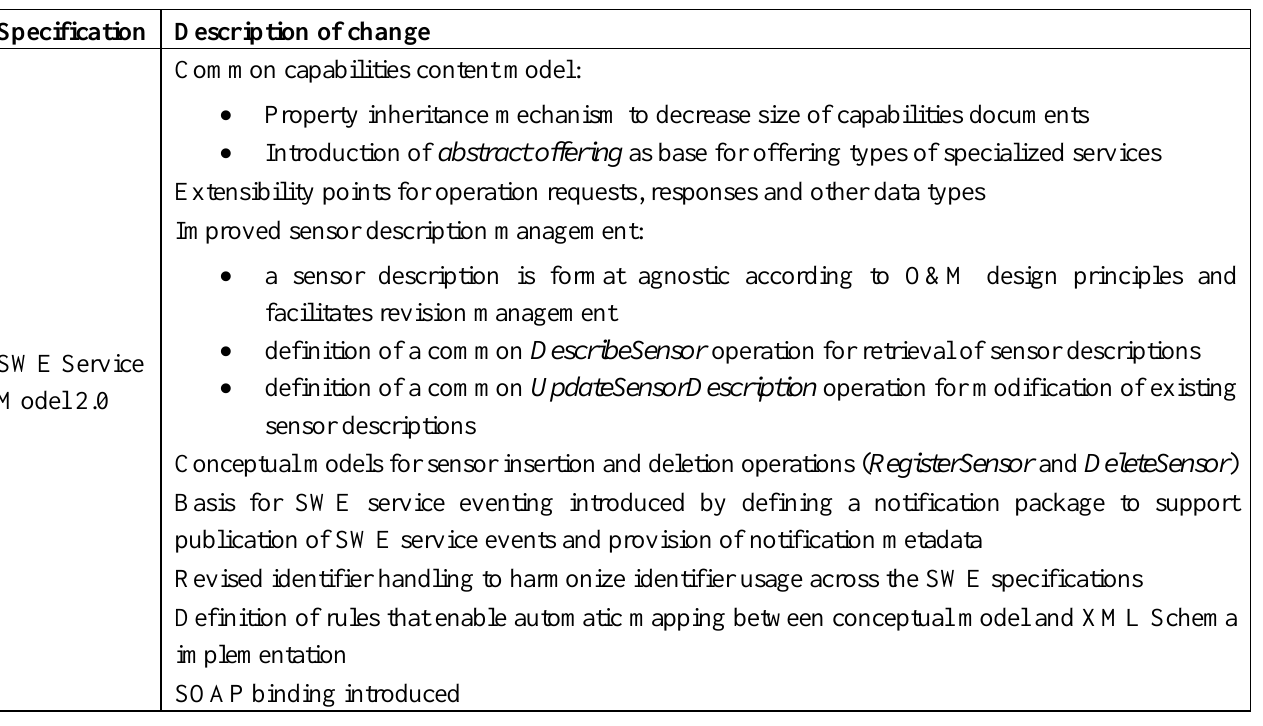
Table 2. Major changes introduced by SWE Service Model